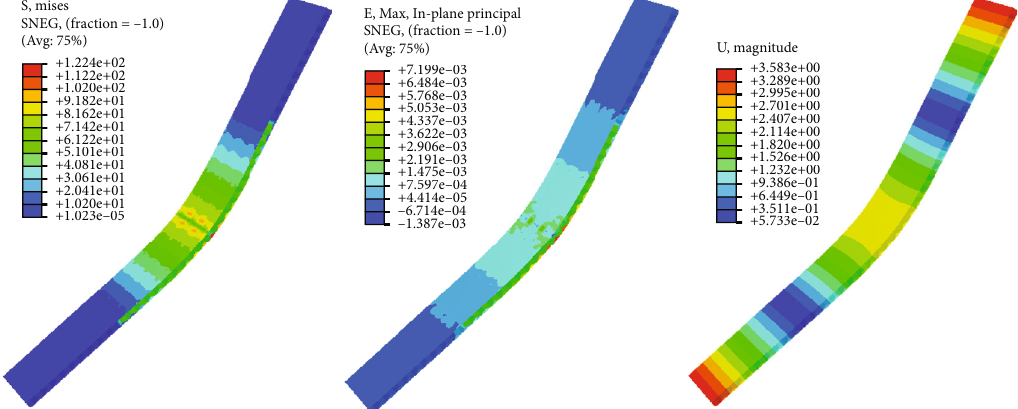
Figure 8: Stress, strain, and displacement nephograms of actual model from the upper angle.